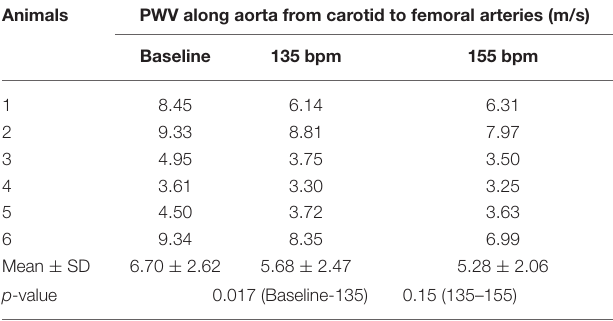
Frontiers in Physiology |